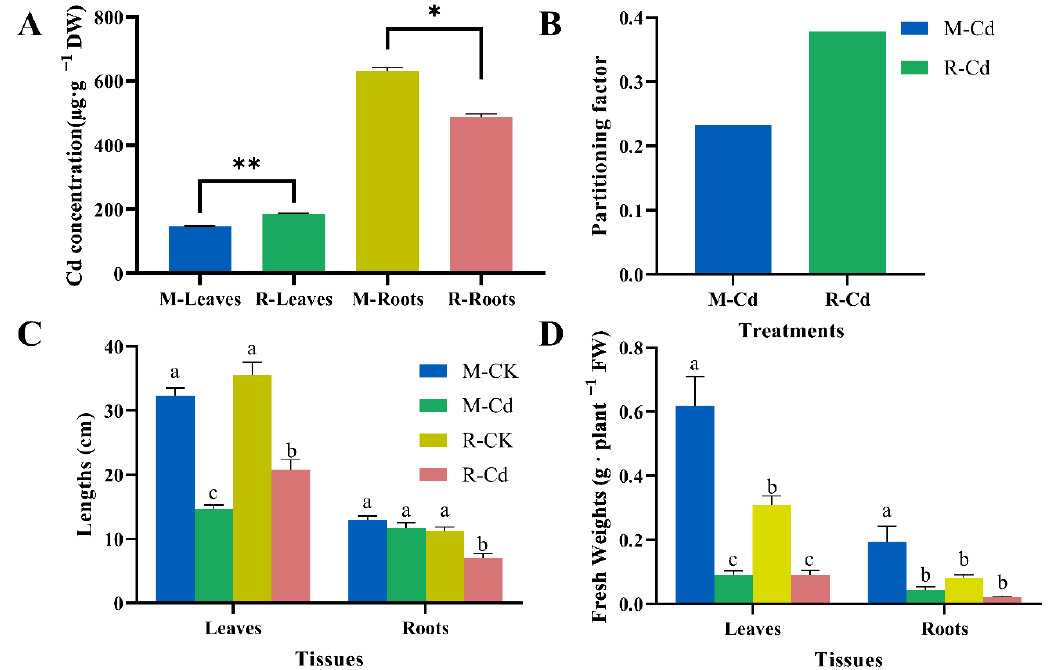
Figure 1. The Cd accumulation, distribution in Kentucky bluegrass, and the effect of it on growth in leaves and roots of M and R genotypes. ( A ) The Cd concentration in the leaves and roots in M and R genotypes after 28 d of Cd treatment. ( B ) Partitioning factor of Cd in M and R genotypes. ( C ) The effect of Cd on the length of leaves and roots. ( D ) The effect of Cd on the fresh weight of leaves and roots. The significant differences of Cd concentration were based on Student’s t -test. * p < 0.05, ** p < 0.01. The significant differences between M and R genotype were based on one-way ANOVA. The different letters indicate that the difference is significant at a 0.05 level. Data were showed by “means ± SE” . CK and Cd represent treatments of 0 and 1000 μM Cd, respectively. 3.2. Effects of Cd on Antioxidant Enzyme Activity Given the positive role of antioxidant enzymes in ROS scavenging, the activities of POD, SOD, CAT, and APX were determined (Figure 2). Following Cd stress, the POD and SOD activity of the leaves and roots of the M and R genotypes was significantly upregu- lated ( p < 0.05, Figure 2A–D). However, the SOD activity in the roots of the R genotype was inhibited at 21 d and 28 d after Cd stress ( p < 0.05, Figure 2D). In addition, the CAT and APX activities in the leaves and roots of the R genotype and the roots of the M geno- type were significantly inhibited by Cd stress ( p < 0.05, Figure 2E–H). In the leaves of the M genotype, the CAT activity was significantly inhibited ( p < 0.05), while the APX activity was upregulated after Cd stress ( p < 0.05, Figure 2E,G). We also observed that the soluble protein content was significantly decreased in the leaves but increased in the roots by Cd ( p < 0.05), and the M genotype possessed a higher soluble protein than R genotypes in leaves and roots after Cd stress (Figure 2I,J).